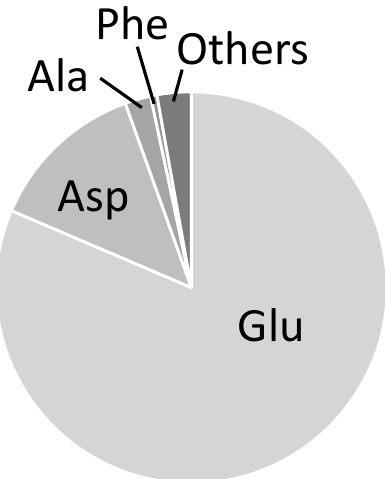
Figure 4. Signal intensities of free amino acids determined by GC-MS. Total